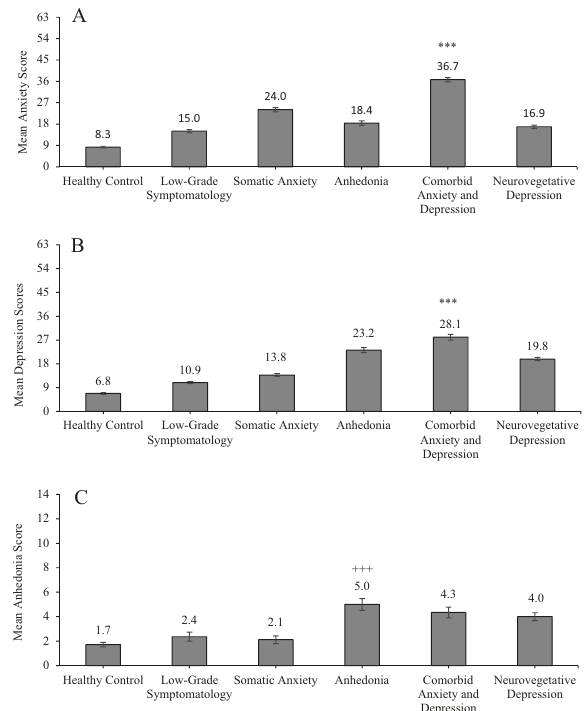
Fig. 2 Anxiety, depression, and anhedonia scores according to symptom cluster (mean ± standard error). *** p < 0.001 compared to all other groups for anxiety ( A ) and depressive ( B ) symptoms, and +++ p < 0.001 compared to healthy control, low-grade symptomatol- ogy, and somatic anxiety clusters for anhedonia symptoms ( C χ 2 (5, N = 536) = 38.661, p < 0.001. In this regard, approximately two-thirds of men fell within the healthy control cluster, whereas this was only the case for just over one-third of women (36.3%). As expected, participants who self-reported having a current mental health condition differed according to cluster membership, χ 2 (5, N = 534) = 112.991, p < 0.001. Speci fi cally, the majority of those that did not report having a mental health condition fell within the healthy control cluster (see Table 2). Descriptive statistics regarding the type of mental health condition reported according to the cluster is displayed in Table 2. Clusters and mood scores It was of interest to con fi rm that the clusters scoring highest on the mood and anxiety PCA loadings would also display the highest total BAI and BDI scores. As expected, anxiety and depressive scores signi fi cantly differed according to cluster membership, F (5,533) = 241.73, p < 0.001, η 2 = 0.69 and F (5,533) = 224.83, p < 0.001, η 2 = 0.68, respectively. Indeed, as indicated in Fig. 2, and con fi rmed by follow-up comparisons, anxiety, and depressive scores were highest in the comorbid anxiety and depression cluster, which differed from all other clusters ( p ’ s < 0.001). As predicted, all symptom cluster groups exhibited higher anxiety and depressive scores compared to healthy controls ( p ’ s < 0.001; Fig. 2A, B). A one-way ANOVA con fi rmed that anhedonia scores differed according to cluster membership, F (5,533) = 16.79, p < 0.001, η 2 = 0.14. Comparisons revealed that the anhedonia cluster had higher mean anhedonia scores compared to the healthy control, p < 0.001, low-grade symptomatology, p < 0.001, and somatic anxiety clusters, p < 0.001 (Fig. 2C). However, the anhedonia cluster did not differ relative to the comorbid anxiety and depression, p = 0.91, or the neurovegetative clusters, p = 0.54, in which depres- sion is a major component. Not unexpectedly and as shown in T a